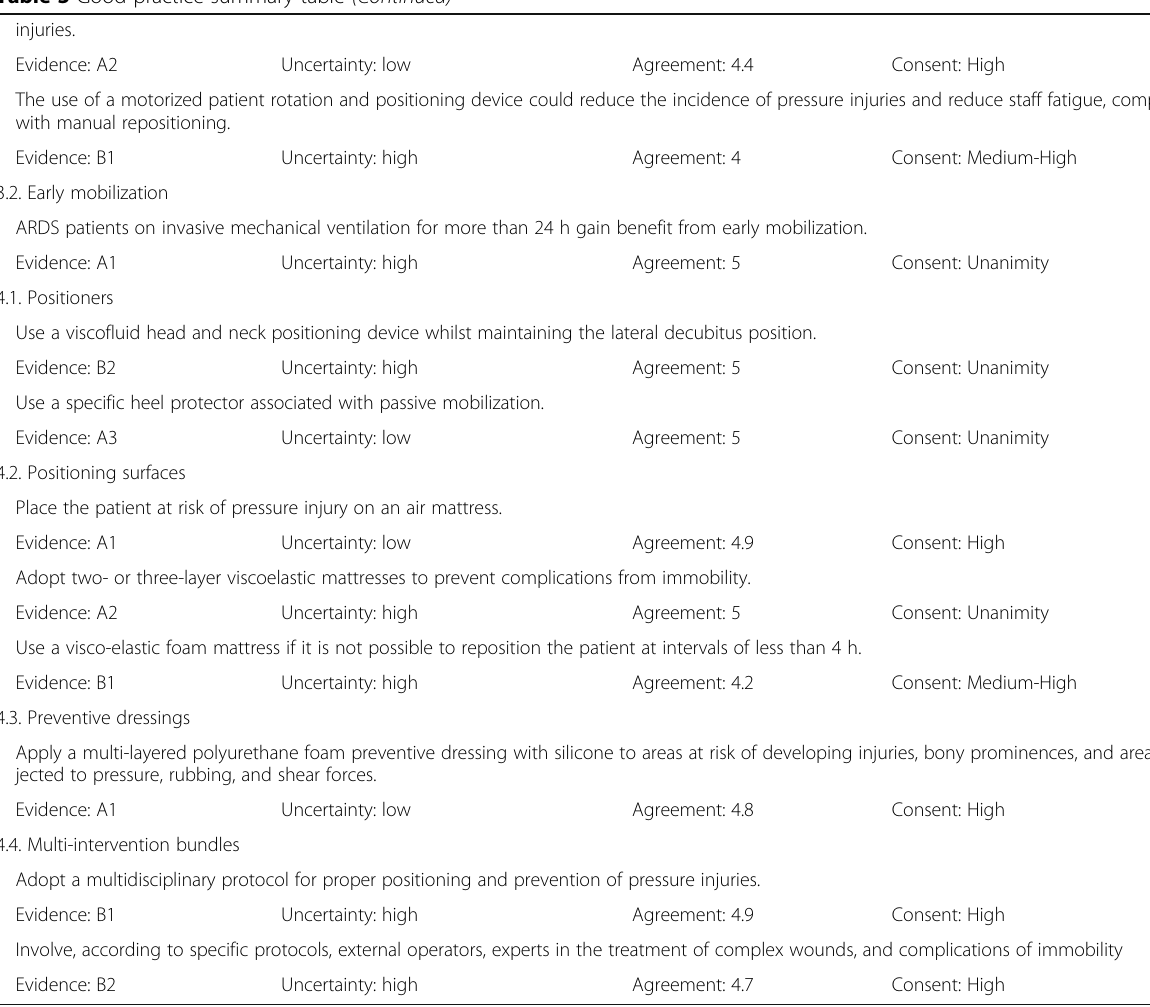
Table 3 Good practice summary table (Continued)